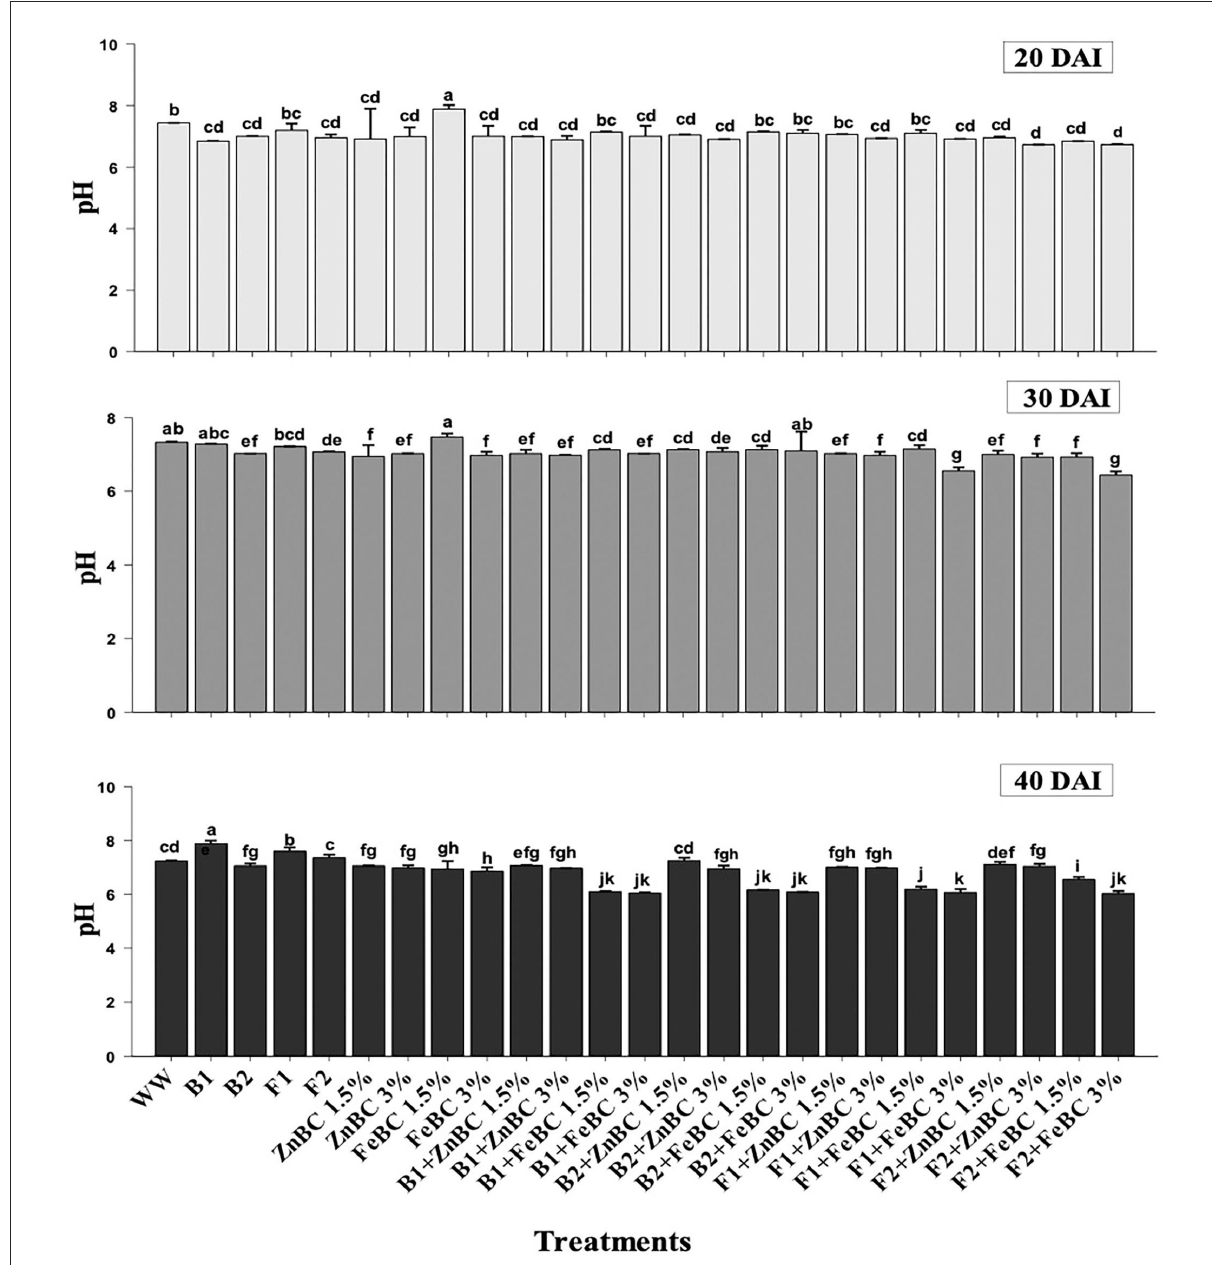
FIGURE5 Comparative analyses of pH for treatments (Mean ± S.D) at 20, 30, and 40 DAI periodic assessments.